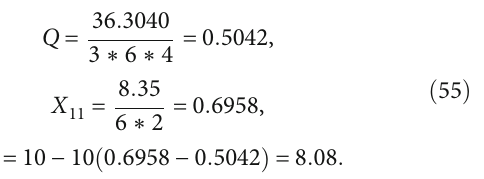
11 -designer bene